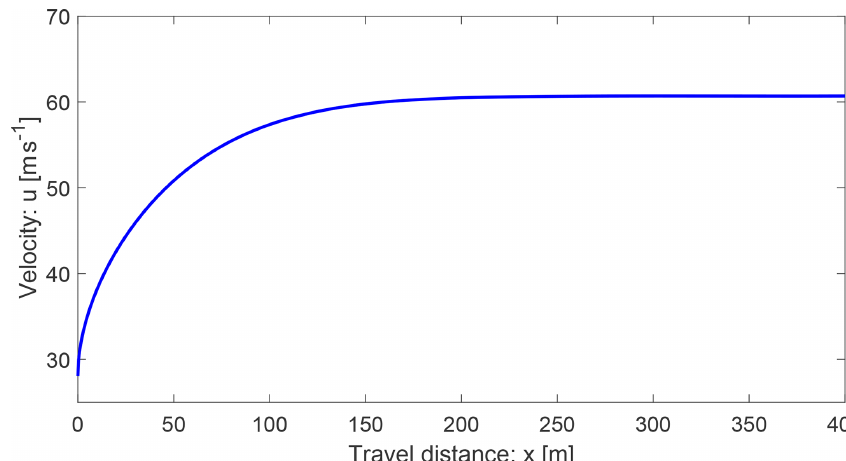
Figure 4. Velocity distribution given by Eq.